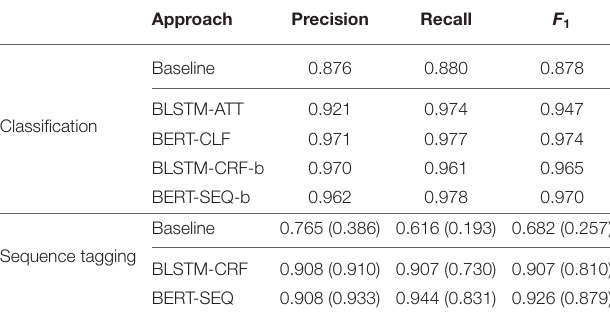
TABLE 2 | Performance on both tasks using five-fold cross validation on